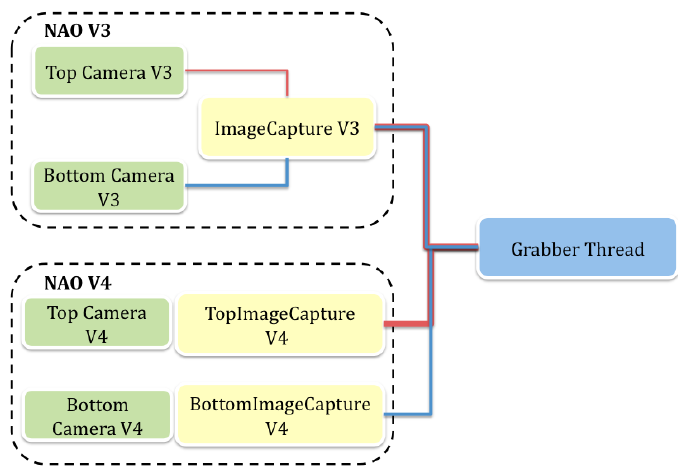
Figure 5. The camera management system offers support for camera activation and switching—depending on each robot